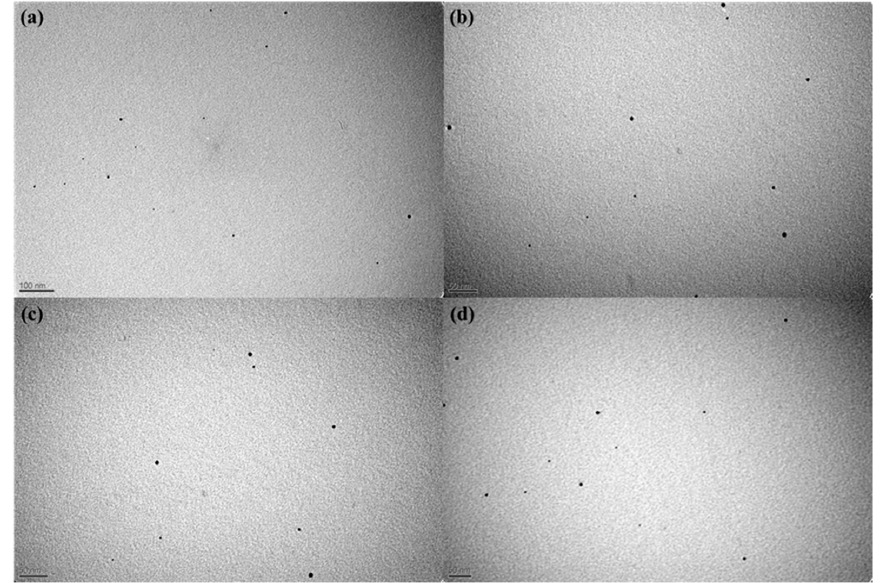
Figure 9. TEM images of Ag NPs taken from different regions( a – d ).